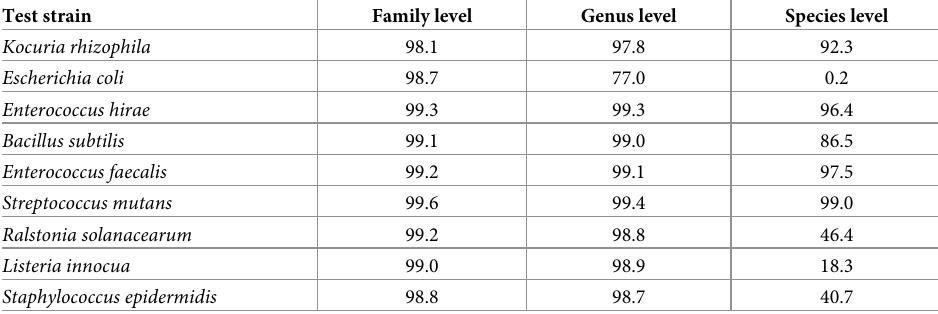
The 16S rRNA sequence reads of nine bacteria obtained using Nanopore sequencer were searched for homology with rRNA database and classified into the species, genus, and family level.